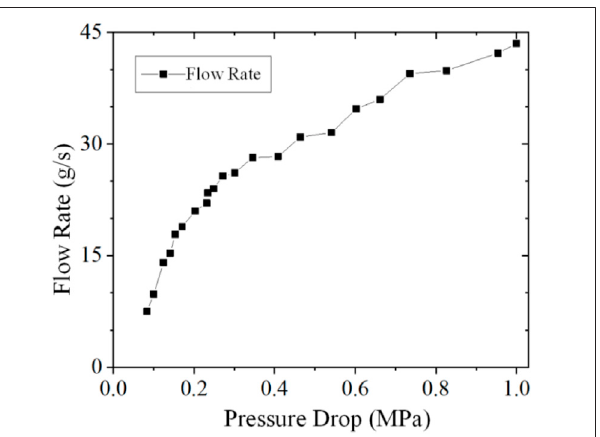
FIGURE 5 | Impacts of the gaseous fl ow rate on the breakup length for different coaxial injectors.